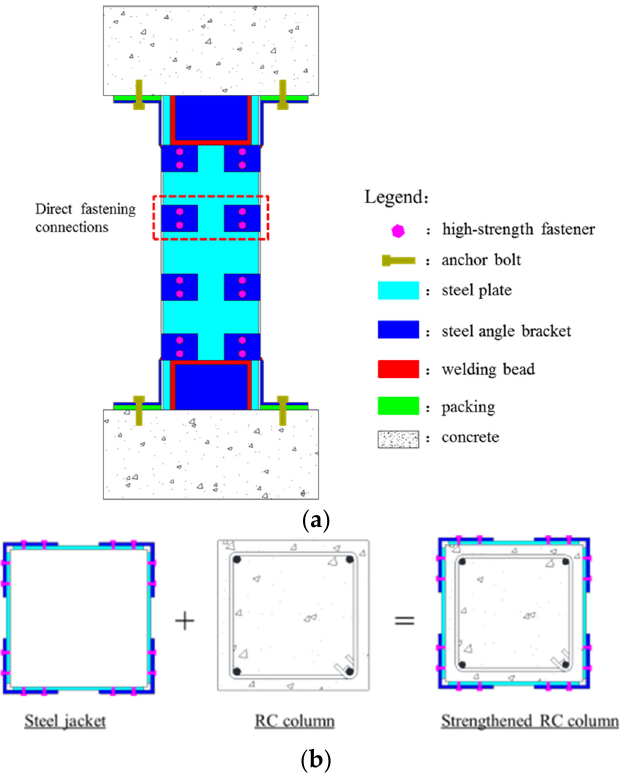
Figure 2. Proposed strengthening scheme: ( a ) front view; ( b ) plane